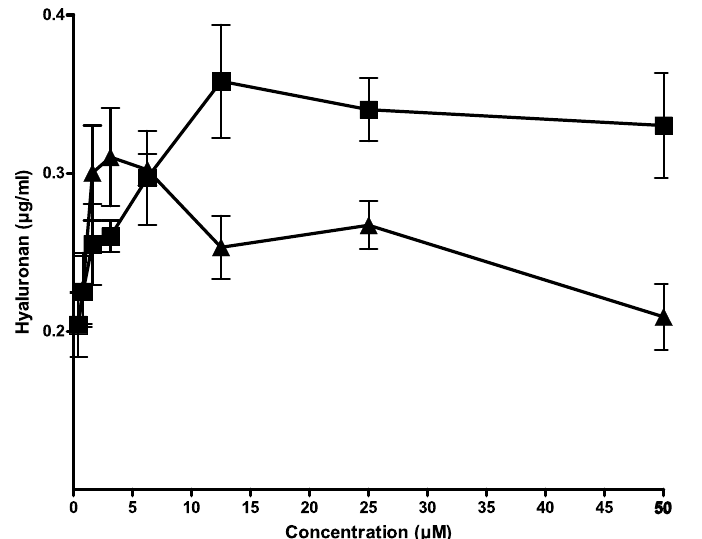
Figure 2. Activation of hyaluronan export by citrate ( ■ ) and isocitrate ( ▲ ) from HMT3552 cells. The error bars indicate the means of two determinations.